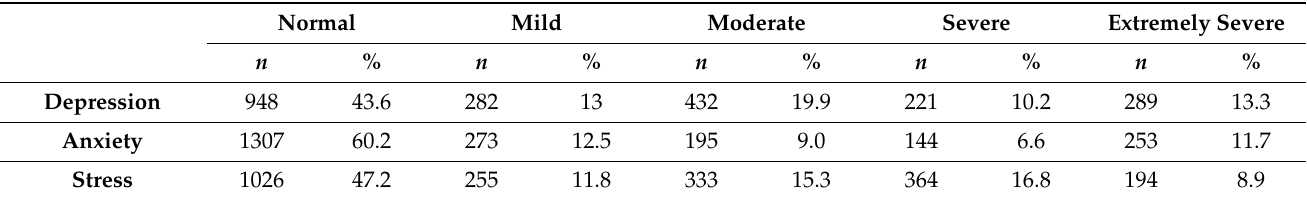
Table 5. The number of students presenting a severity ranges of overall emotional distress, depression, anxiety, and stress